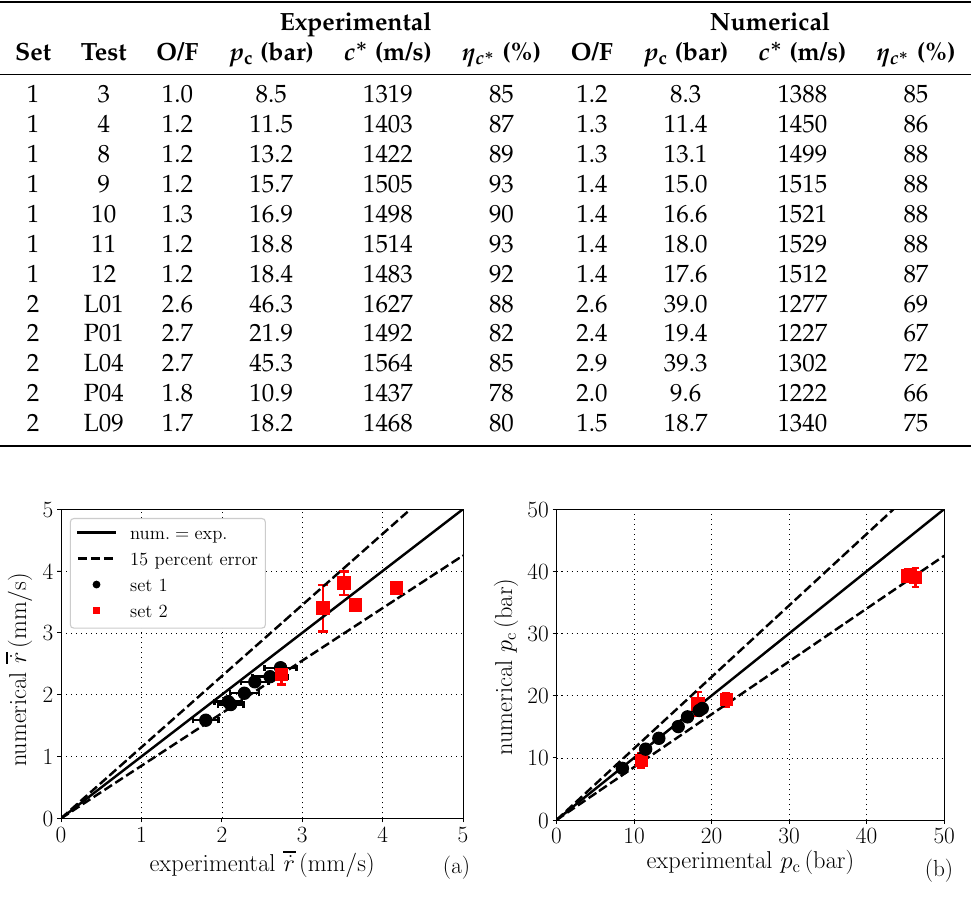
Figure 12. Numerical rebuilding of average regression rate ( a ) and post-chamber pressure ( b ). Experimental uncertainties for the regression rate of set 1 and numerical uncertainties of simulations of set 2 are also